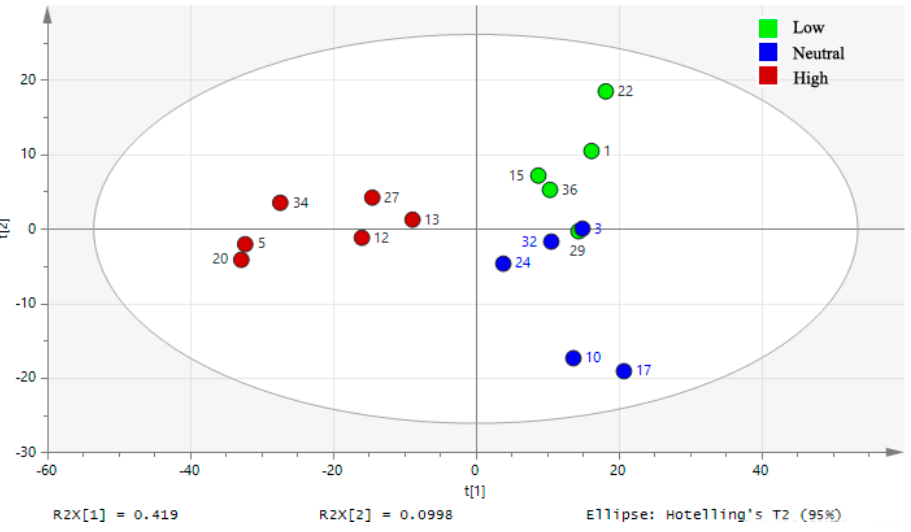
Figure 1. Principle component analysis (PCA) score plot demonstrating the separation of the plasma samples from pigs at 25 kg kept at different ambient temperatures. Low: 18 °C; Neutral: 23 °C; High: 32 °C. Each circle represents an individual plasma sample.